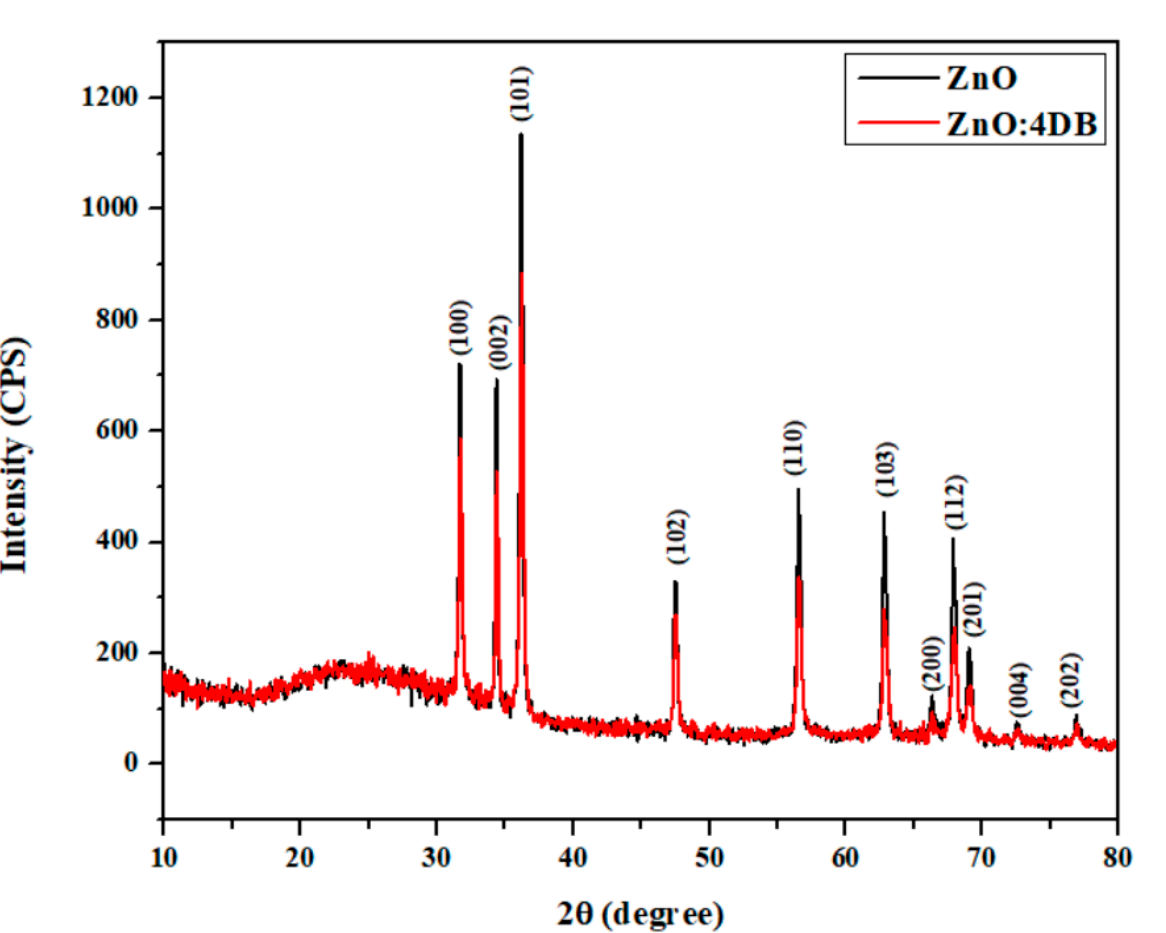
Figure 2. X-ray diffraction patterns of the ZnO NPs and ZnO:4DB NP powders. Table 1. Lattice parameter values of the pure ZnO and ZnO:4DB NPs. Sample